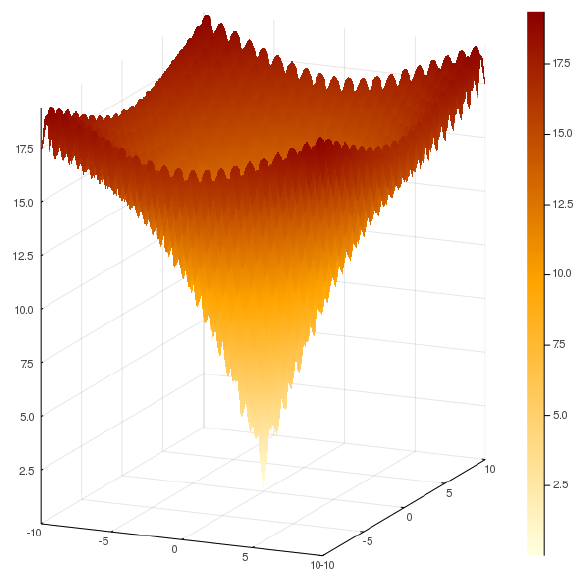
Figure 2. 3D Ackley